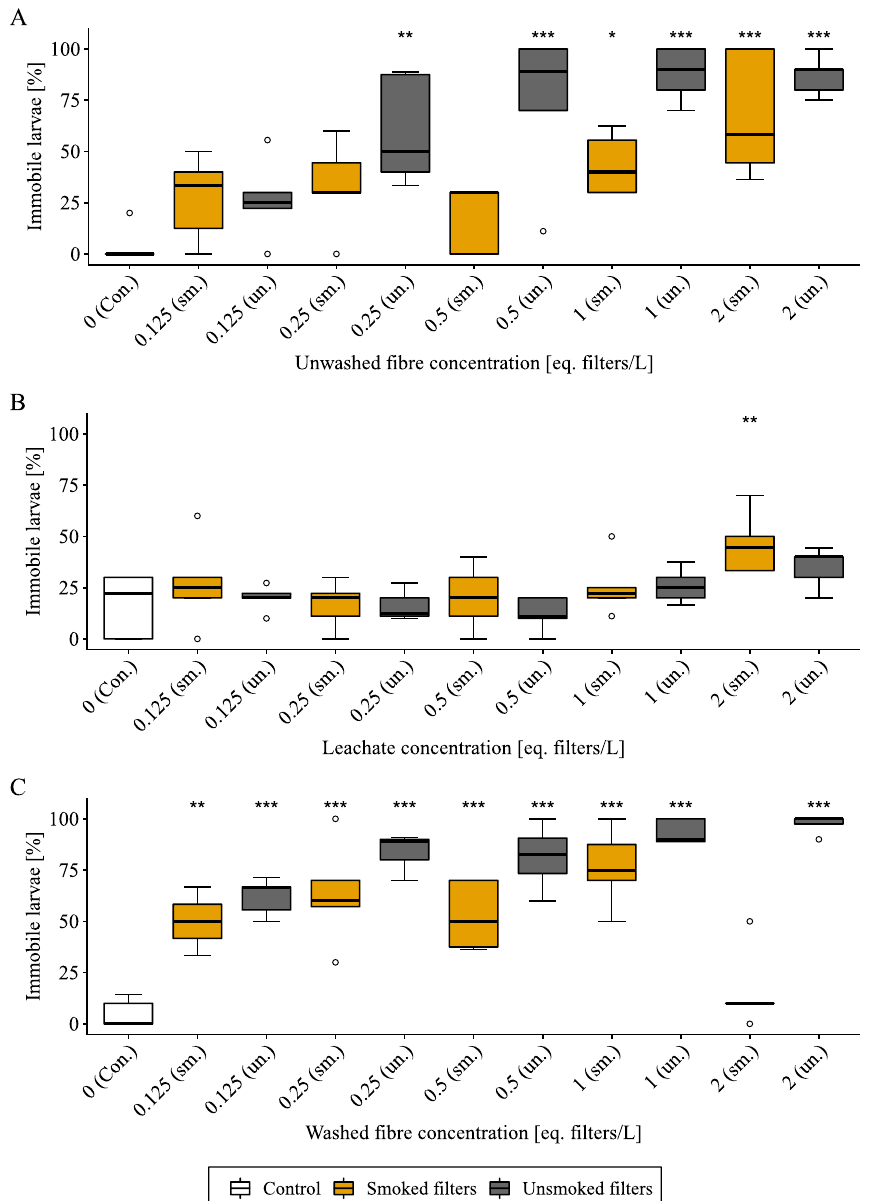
Fig. 3 Immobility of first instar larvae following 48-h exposure experiments. Immobility is presented as the percent immobility in a replicate ( n for all exposure groups ( a 11, N 55) within the unwashed fibre experiment ( A ), leachate experiment ( B ) and washed fibre experiment ( C ). The = = washed fibre experiment had an unbalanced design ( a 11, n 1 ≠ n x , N 50) due to five missing observations. The boxes display the 25%- and = = 75%-quartile, dark lines the median, and the whiskers extend to one and a half times the interquartile range. White circles represent outliers. The asterisks indicate evidence for increased immobility in the treatment groups compared to the control with p < 0.05 for (*), p < 0.01 for (**), p < 0.001 for (***), based on Dunnett test